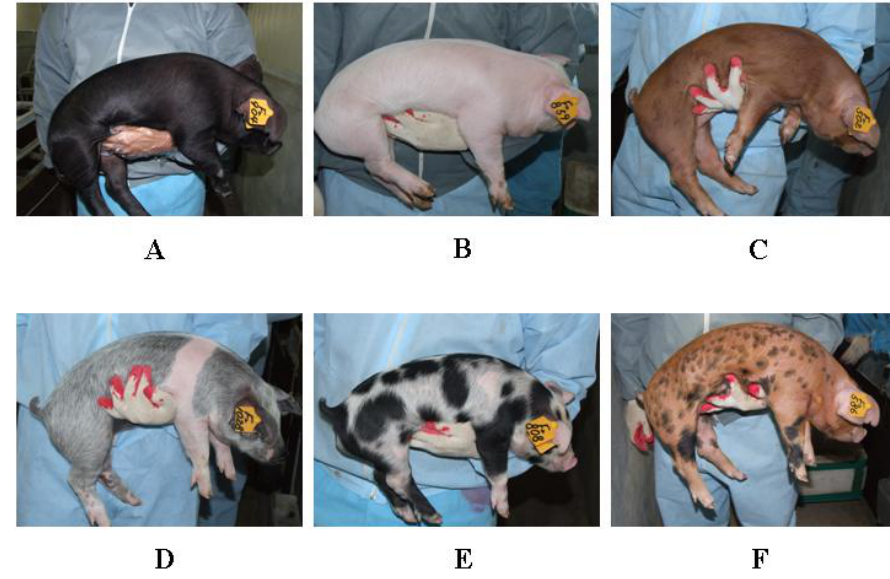
Figure 1. The different coat colors in crossbred pig (KNP  Landrace) F 2